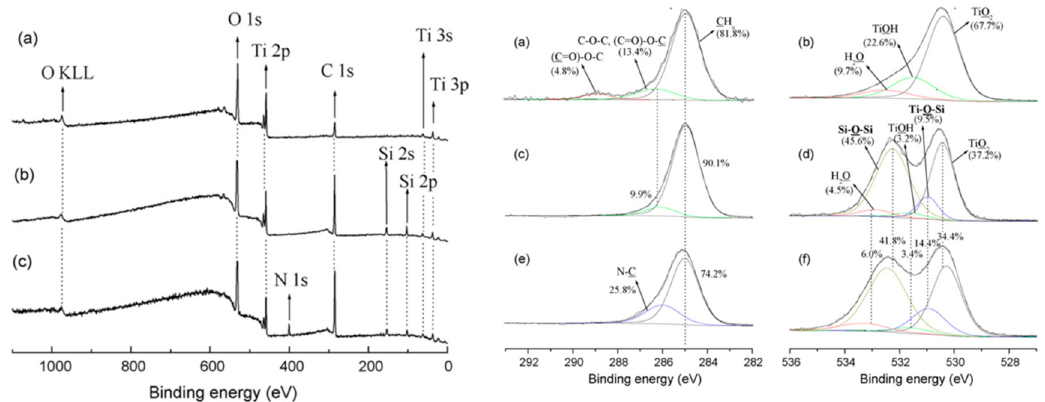
Figure 1. On the left : X-ray photoelectron spectroscopy (XPS) survey spectra of ( a ) titanium substrates and titanium substrates modified (2 h of reaction) by ( b ) HTCS and ( c ) PyHTCS. On the right : XPS of C1s and O1s high resolution spectra of titanium substrates ( a , b ) and titanium substrates modified (2 h of reaction) by HTCS ( c , d ) PyHTCS ( e , f ). (Reprinted with permission from [35], Elsevier 2008